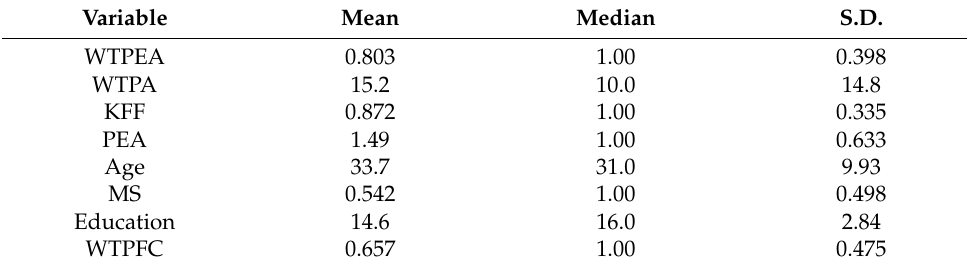
Table 2. Summary statistics (observations 1–1200).